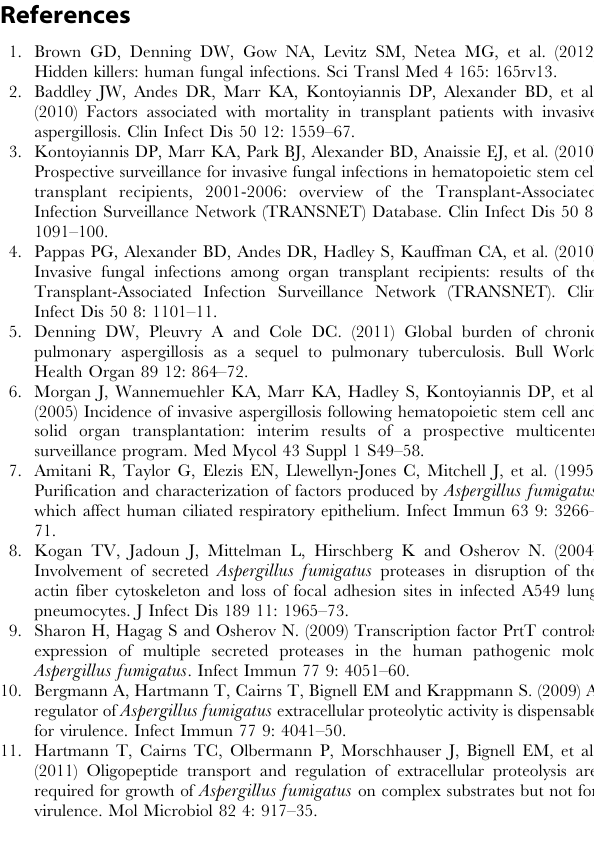
Figure S8 qPCR validation of microarray data. Accuracy of microarray data was independently verified by quantitative RT-PCR on selected transcripts, values (A) and graphical representation (B) . Oligonucleotides used for this analysis are detailed in Table S2. Fold change due to treatment (-1/ D C T ) was calculated using A. fumigatus Act1 (AFUA_6G04740) as a house- keeping gene. Figure S9 Qualitative analysis of A. fumigatus protease activity in cell culture filtrates. Culture supernatant (50 m l of supplemented DMEM + A549 cell culture, 10 6 spores/ml) was spotted onto X-ray film, incubated at 42 u C and washed after overnight digestion with water. Positive control is represented by trypsin (50 BAEE units). Trypsin hydrolyzes N-benzoyl-L-arginine ethyl ester (BAEE) and one BAEE unit equals the amount of the enzyme determining an increase in absorbance of 0.001 per minute at 25 u C and 253 nm. Figure S10 Electron microscopy of A. fumigatus D pac- C ATCC mutant and the respective parental isolate at 0, 4, 8 and 16 hr of growth. Figure S11 Nystatin-mediated killing of wild type and D pacC mutant spores. Figure S12 Adhesion of wild type and D pacC mutant spores to plastic and A549 monolayers.